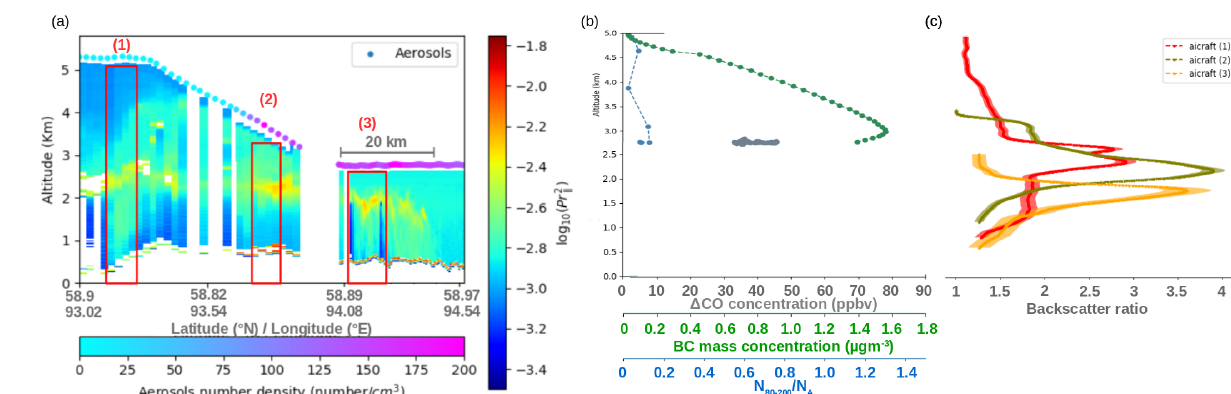
( PR 2 ) on 19 July 2013 at 06 UT. Calibration constant is 491,724 ± 10%. Figure 11. ( a ) Vertical cross-section of aircraft log 10 Grimm aerosol concentrations in particle.cm − 3 are shown at the aircraft altitude. ( b ) Vertical profiles of ∆ CO in ppbv (grey), BC in µ g.m − 3 (green) and ratio N 80 − 200 /N A (blue dashed line) for the descent at 94 ◦ E. ( c ) Backscatter ratio vertical profile for the lidar data in the red box.